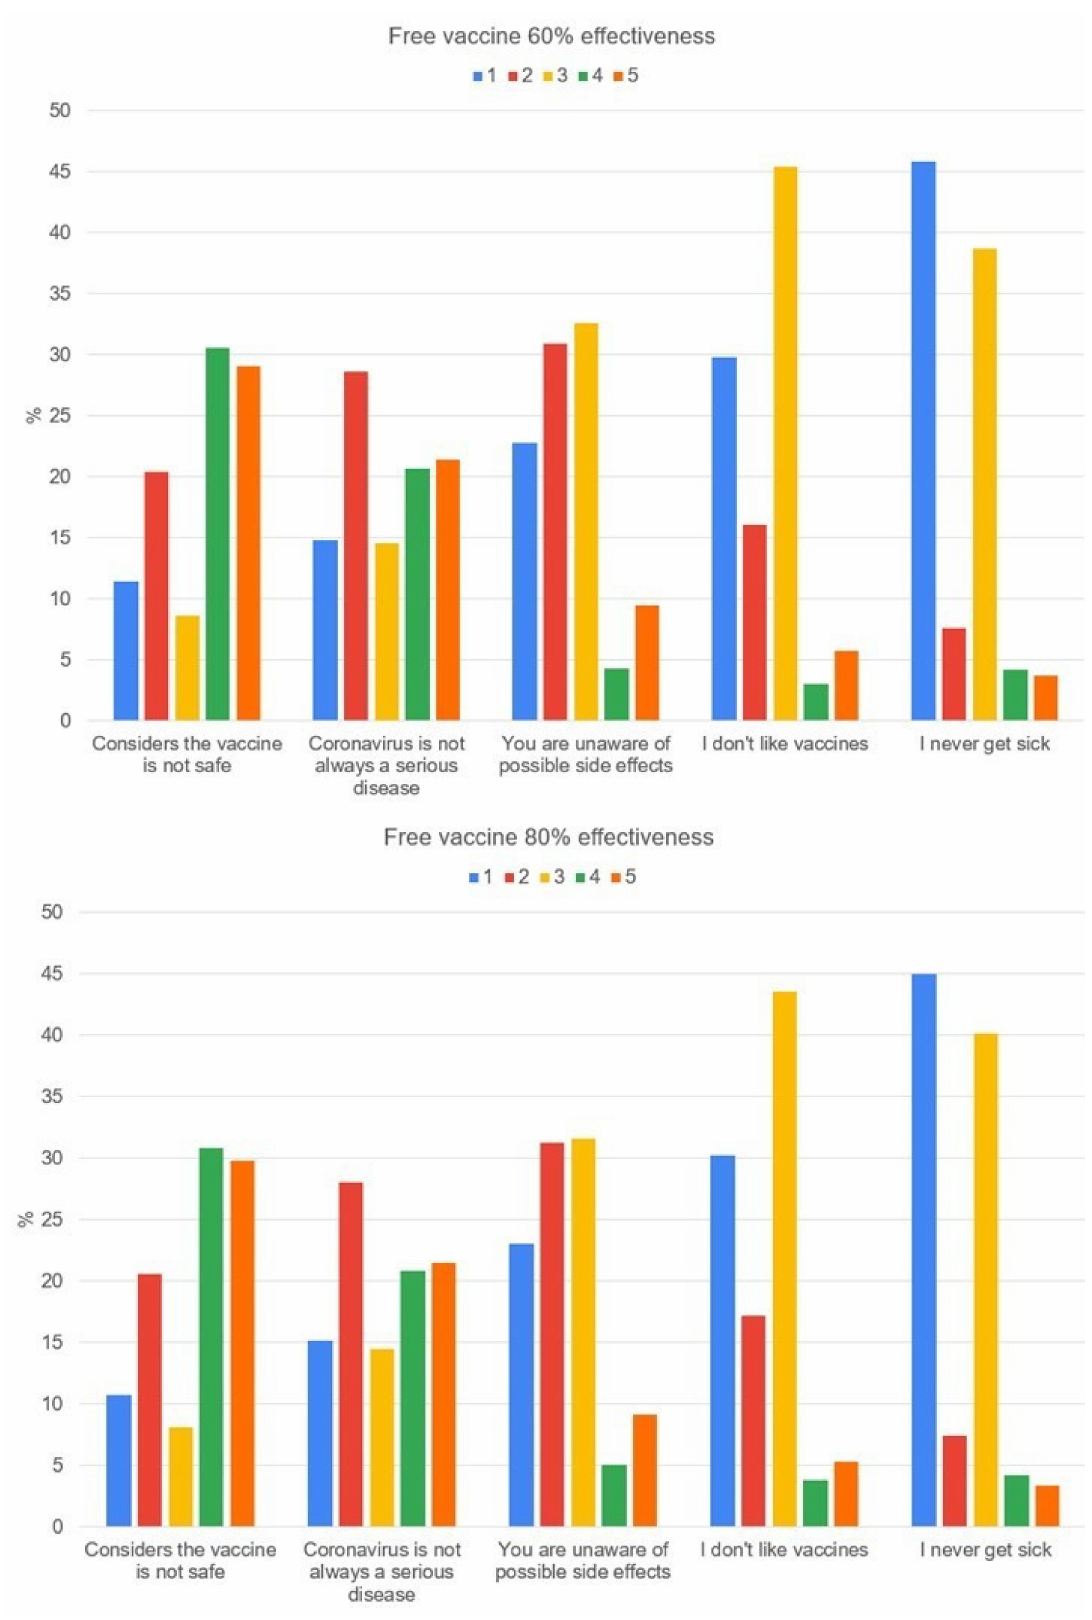
Figure 2. The reason why the participant would not accept a free vaccination with an effectiveness of 60% and 80%, against COVID-19, one (1) being the least important and five (5) the most important (2–4) intermediate